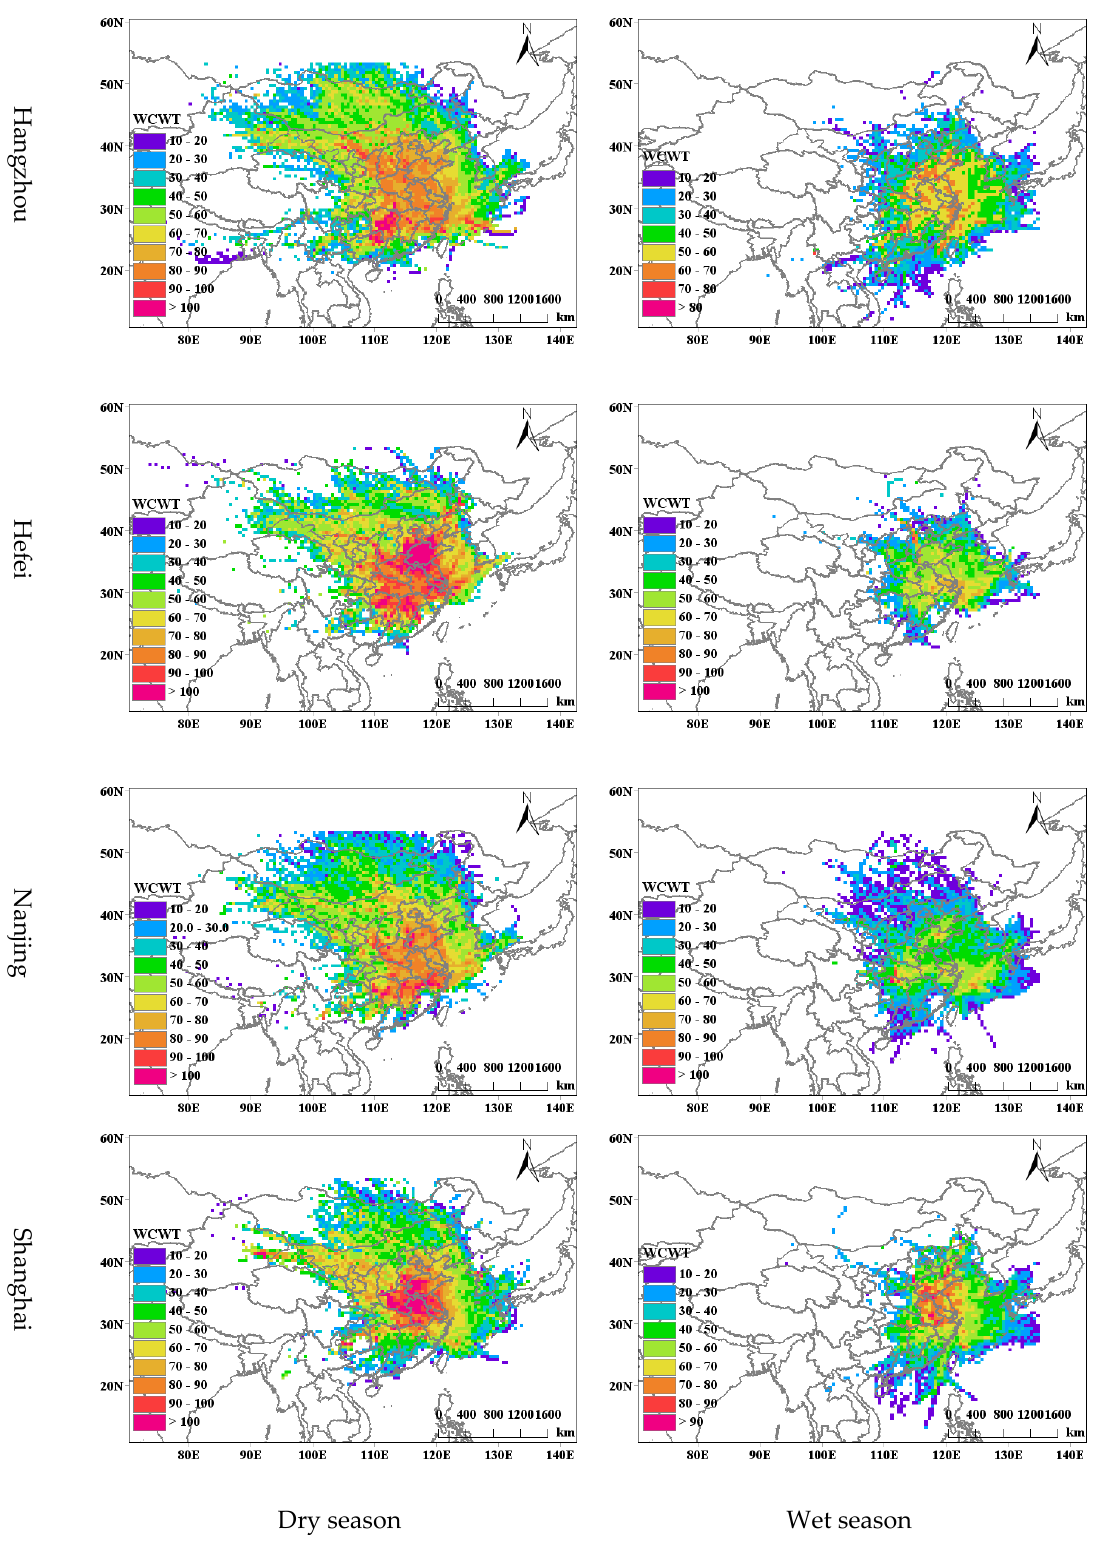
Figure 6. Concentration weighted trajectories for PM 2.5 in dry and wet seasons in YRDUA. Weighted concentration weighted field (WCWT) was used to analyze the pollution level of different trajectories. The distribution characteristics of WCWT and Weighted potential source contribution function (WPSCF) were similar in the dry season and wet